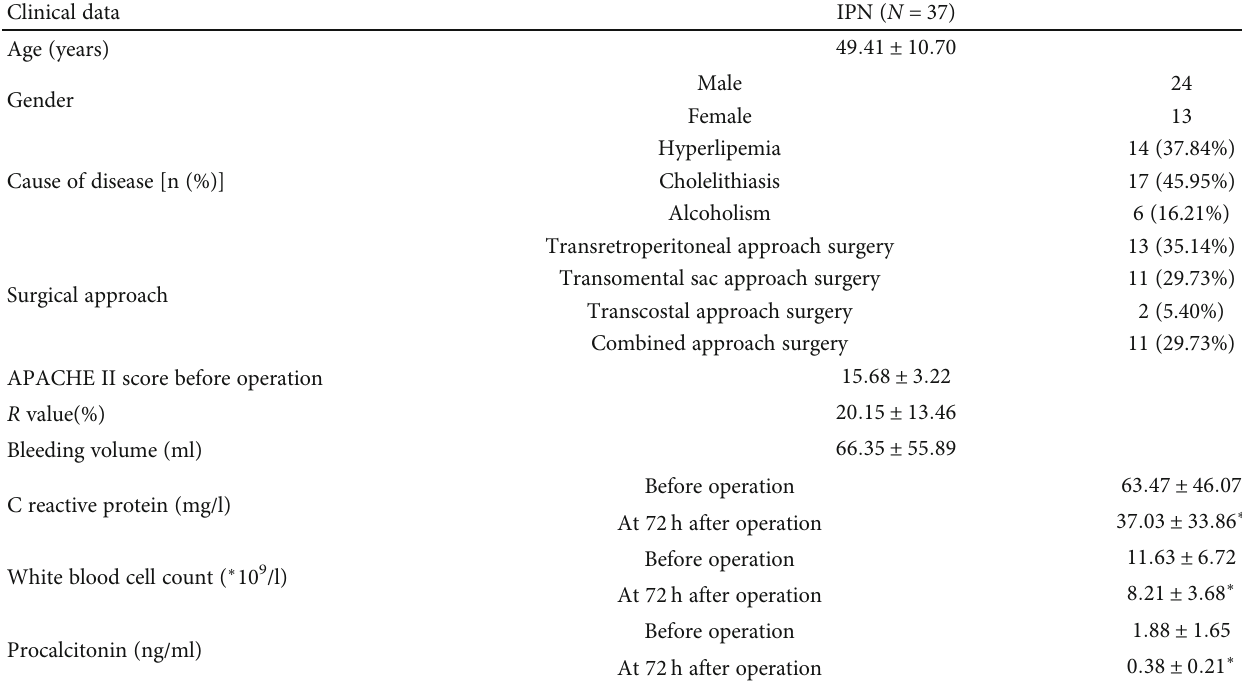
Table 1: Clinical data of the 37 patients with infected necrotizing pancreatitis. Clinical